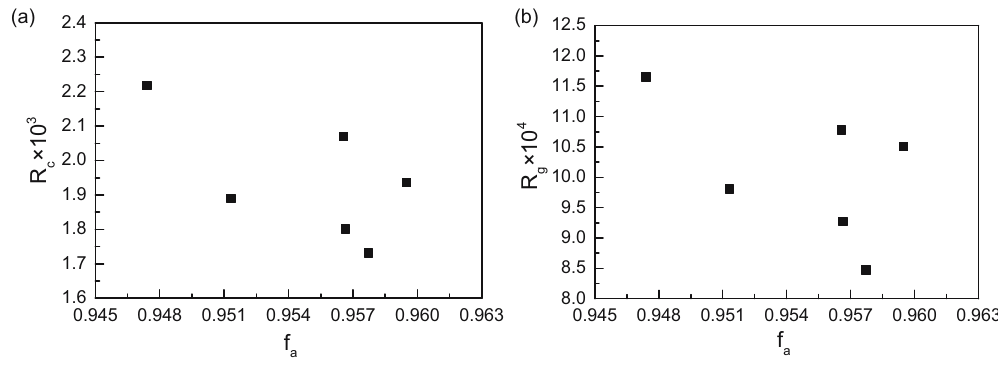
Figure 7: Relationships of semi - coke f a with combustion and gasi fi cation reactivity indexes. ( a ) f a vs R c ; ( b ) f a vs R g